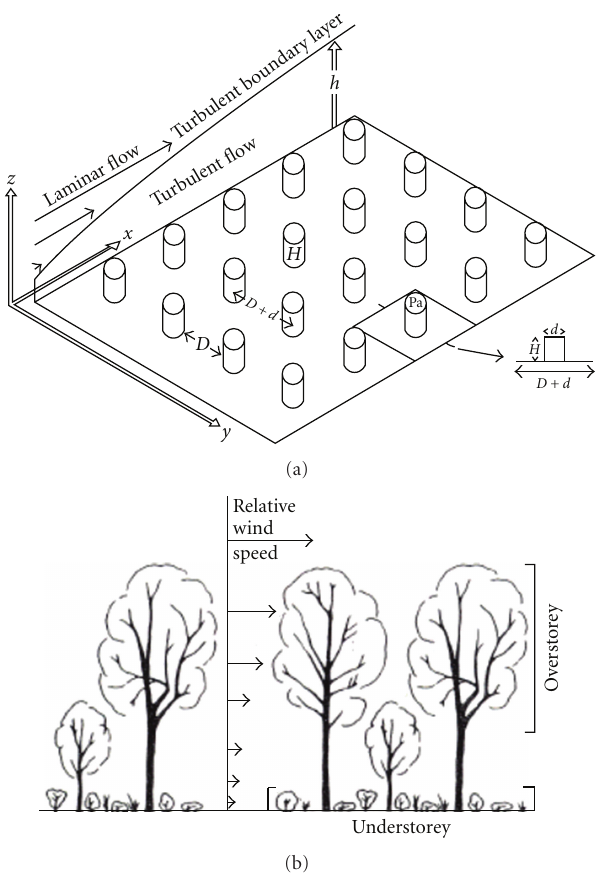
Figure 5: (a) A wind tunnel experiment to assess the e ff ect of surface roughness on the laminar flow of air over an array of small cylinders of di ff erent diameter ( d ) and height ( h ) ([118]; see[5, Figure 11.9]). (b) A sketch showing the variation in resistance of overstorey and understorey strata in a plant community to the laminar flow of wind ([109]; see [5, Figure